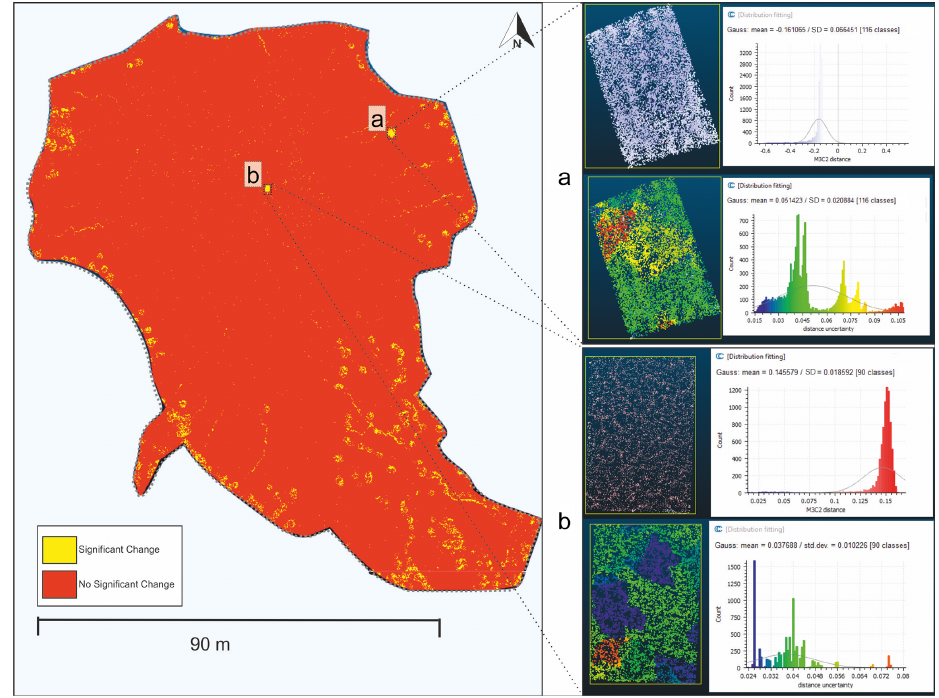
Figure 14. Enlargement of the comparison between the point clouds of the 13 September 2019 and 14 October 2019 campaigns with significant changes. Two significant changes ( a and b ) are shown, which highlight an anthropogenic action, i.e., the movement of a wooden platform about 15cm high. ( a , upper part) A lowering of an average height of 16cm is detected, and the Gaussian distribution of the M3C2-PM distances with the mean and the standard deviation is shown. ( a , lower part) The distance uncertainty varies spatially with an average value of about 5cm, and the Gaussian distribution of the M3C2-PM distances with the mean and the standard deviation is shown. ( b , upper part) An increase in height of 14cm is recorded, and the Gaussian distribution of the M3C2-PM distances with the mean and the standard deviation is shown. ( b , lower part) The distance uncertainty has an average value of about 3cm, and the Gaussian distribution of the M3C2-PM distances with the mean and the standard deviation is shown. The reference system is WGS 84/UTM zone